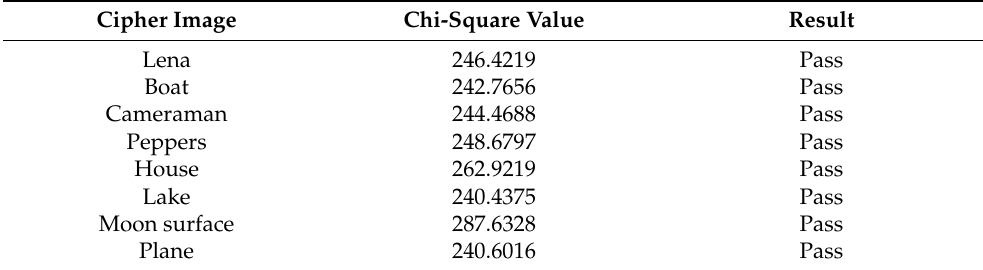
Table 3. Chi-square test results of encrypted images. Cipher Image Chi-Square Value